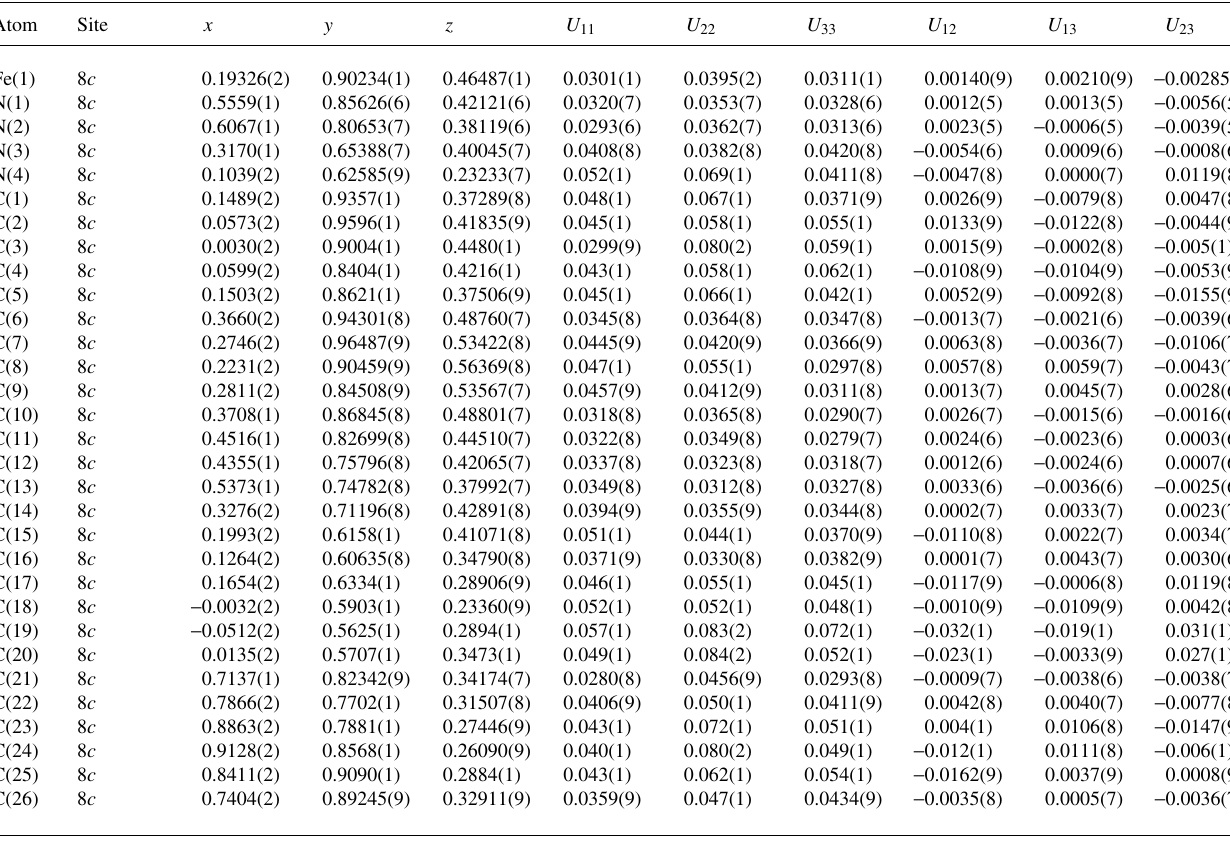
Table 3. Atomic coordinates and displacement parameters (in Å 2 )